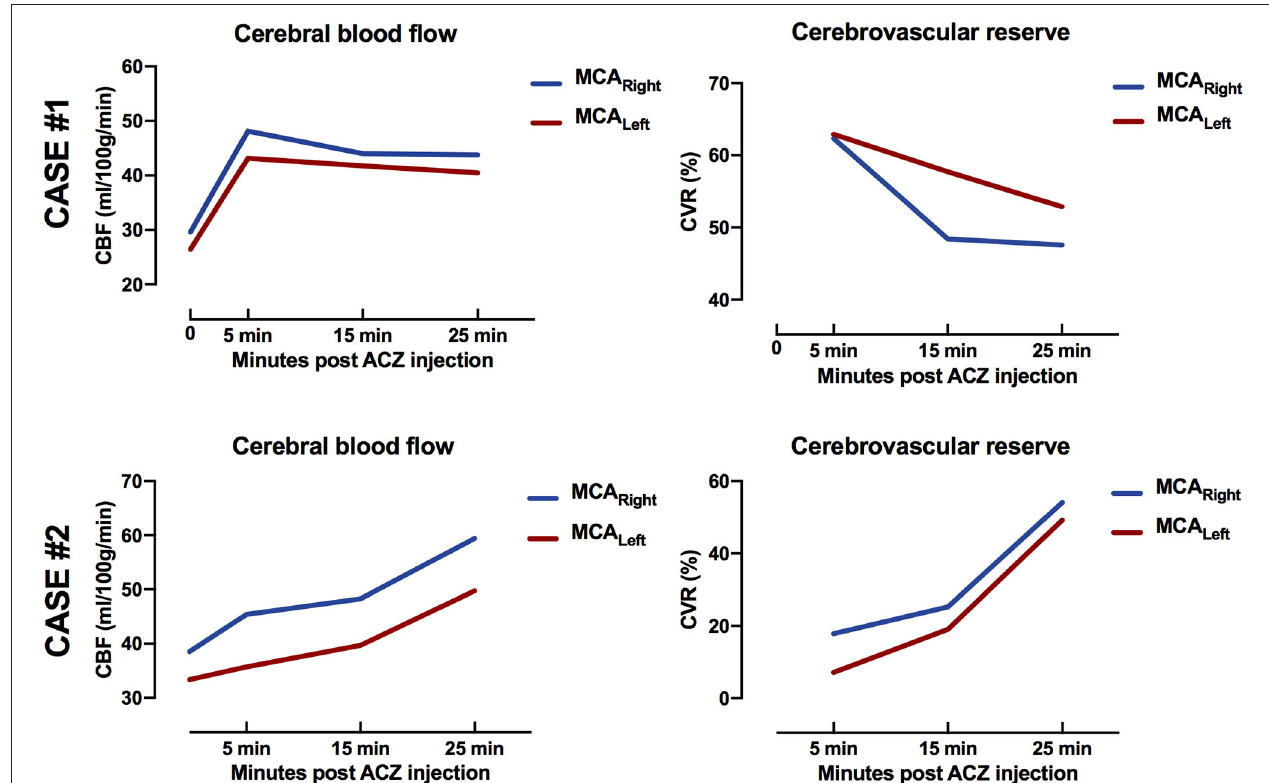
FIGURE 4 | Case #1 (top row): Female, aged 51 years, with bilateral moyamoya disease [Suzuki grade III left internal carotid artery (ICA) and right ICA]. Magnetic resonance imaging was performed for preoperative evaluation. Temporal response of cerebral blood flow (CBF) and cerebrovascular reserve (CVR) peaked at 5min post-acetazolamide injection. Case #2. (bottom row): Male, aged 14 years, with unilateral moyamoya disease (Suzuki grade II left ICA). Magnetic resonance imaging was performed after indirect revascularisation surgery of the left hemisphere. Temporal response of CBF and CVR increased for all time points post-acetazolamide injection. Notice difference between 15 min (left 19% and right 25%) and 25min (left 49% and right 54%) post-acetazolamide injection. 5 min post-ACZ injection and then decreased successively.